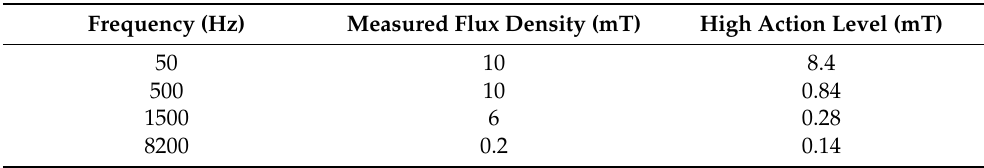
Table 1. The AURA system has been used at several different workplaces. So far, there have been no electromagnetic compatibility issues regarding the smartphones. This table shows the frequencies and the maximum measured flux densities of the encountered magnetic fields. The high action level limit value is given as a reference. The system must be able to measure at least this flux density to perform a meaningful assessment of the